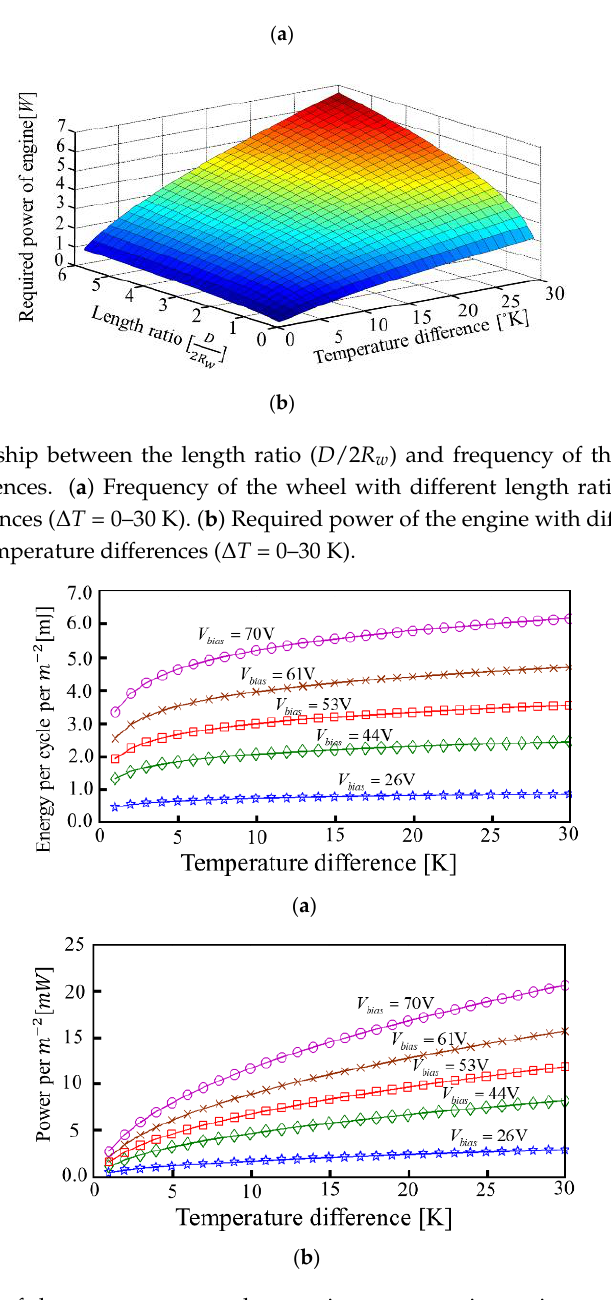
Figure 10. Results of the energy generated per unit area per unit rotating cycle at the wheel for various temperature differences. ( a ) The energy produced with the Stirling engine energy harvester at different bias voltages. ( b ) The power produced with the Stirling engine energy harvester at different bias voltages.